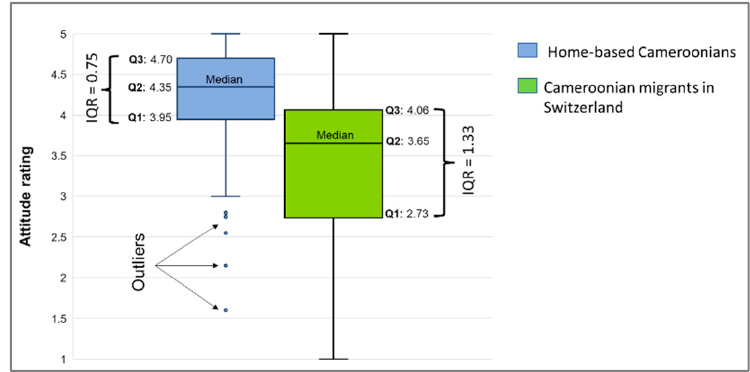
Figure 3. Boxplot analysis of attitudes in the home-based and diaspora groups.